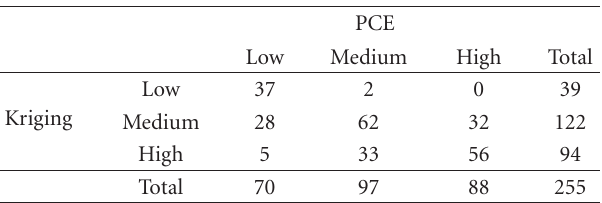
Table 2: Comparison between PCE and kriging prevalences for the 255